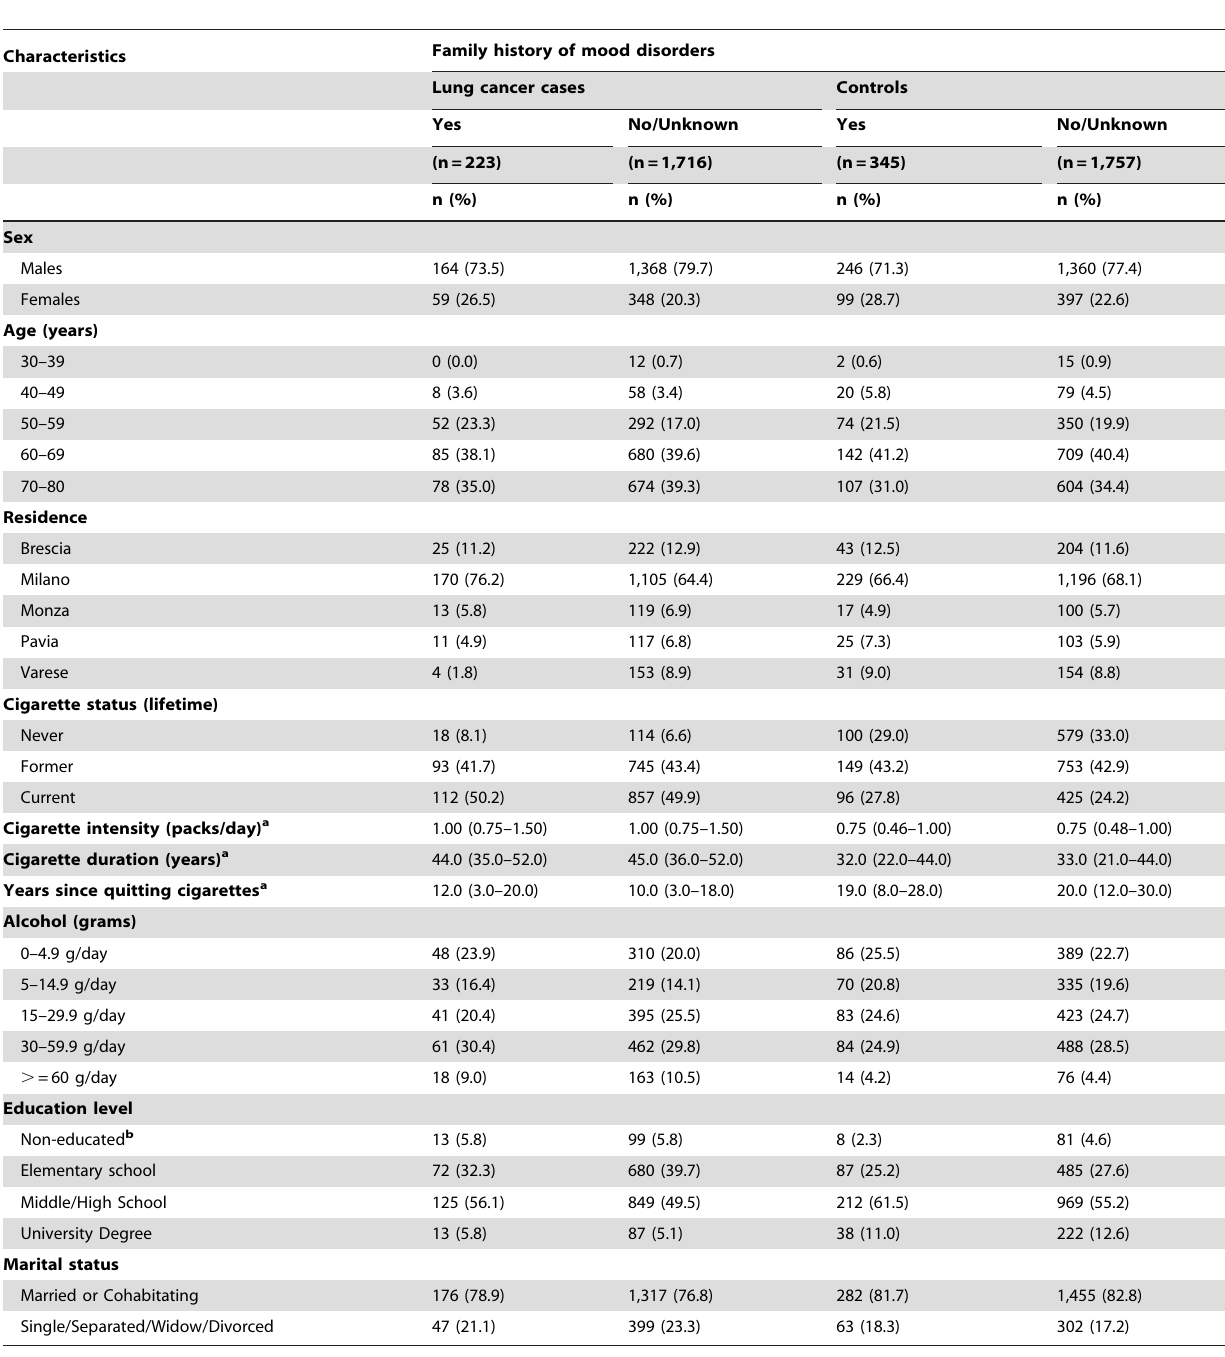
Table 2. Numbers and percentages of cases and controls with a first-degree relative (mother, father, siblings, or children) with history of mood disorders by demographic and behavioral characteristics in the EAGLE Study, Italy,